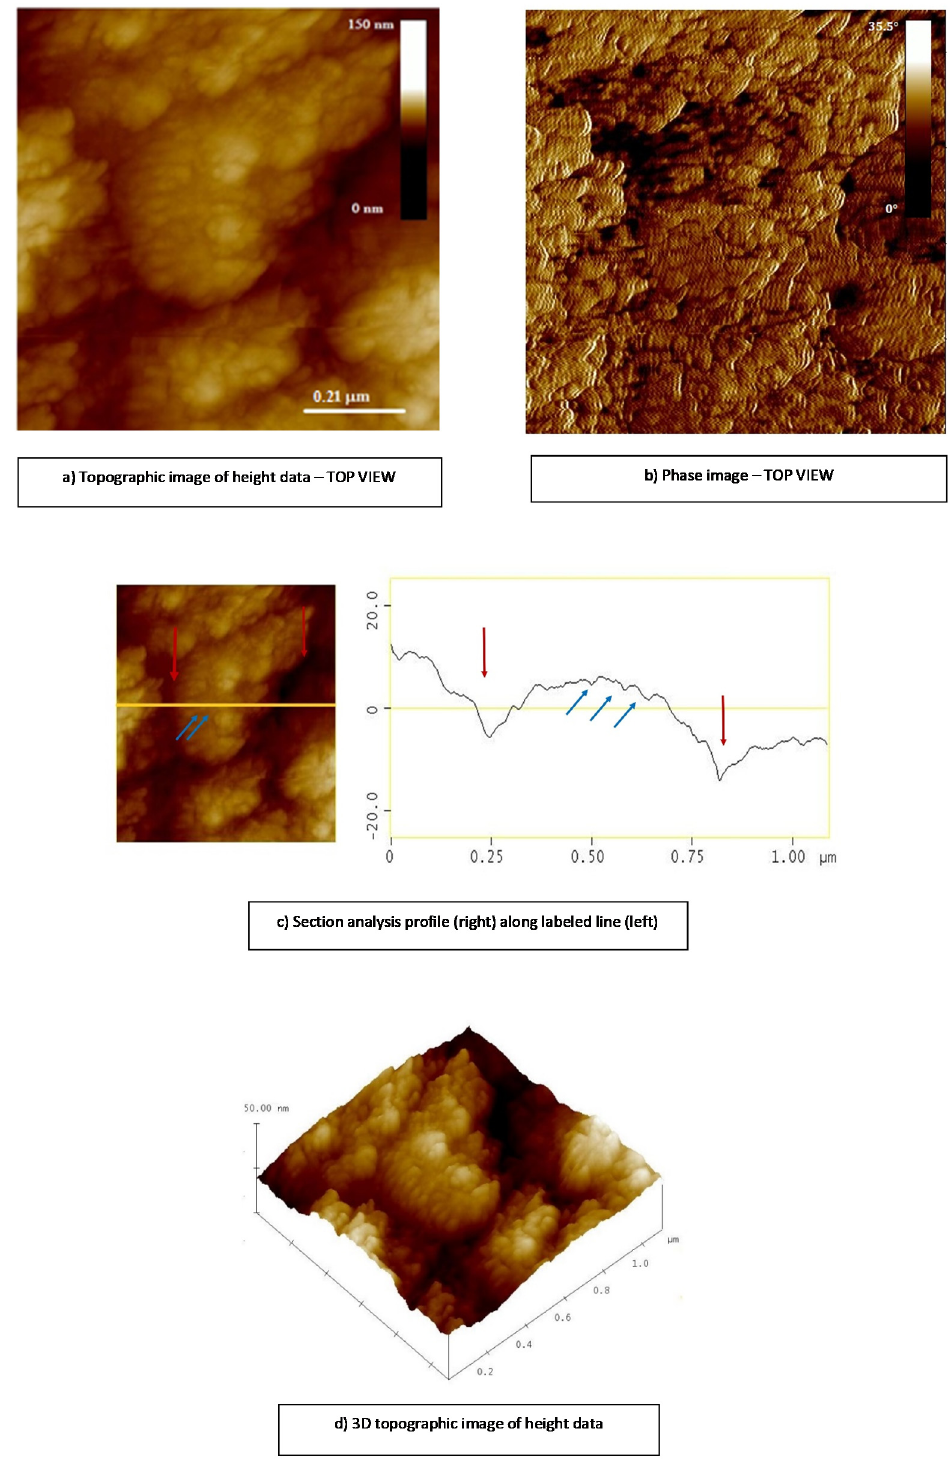
Figure 5. Top view of 2D-height data ( a ) 2D—phase data ( b ). A cross-section profile ( c ) along the yellow line (left) corresponds to the surface characteristics and 3D—height data ( d ) of CS/(ALG/(Ca+Cu)) microcapsules.